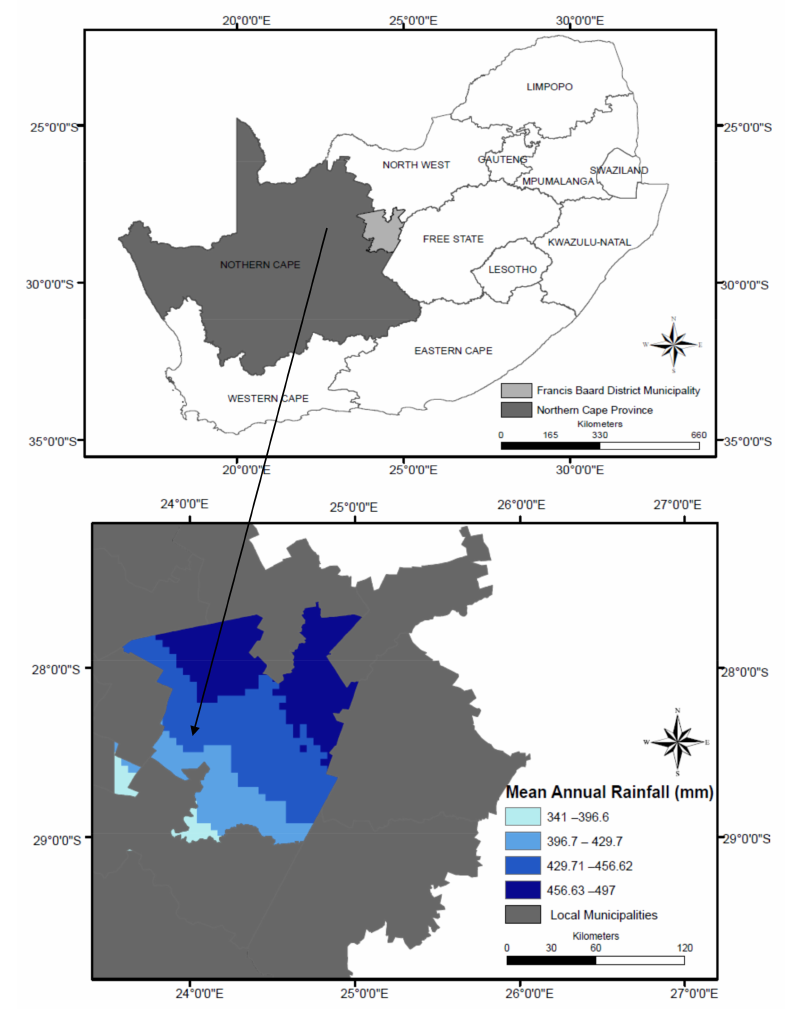
Figure 3. A spatial distribution map of the precipitation in FBDM. Source: Author’s compilation and FBDM